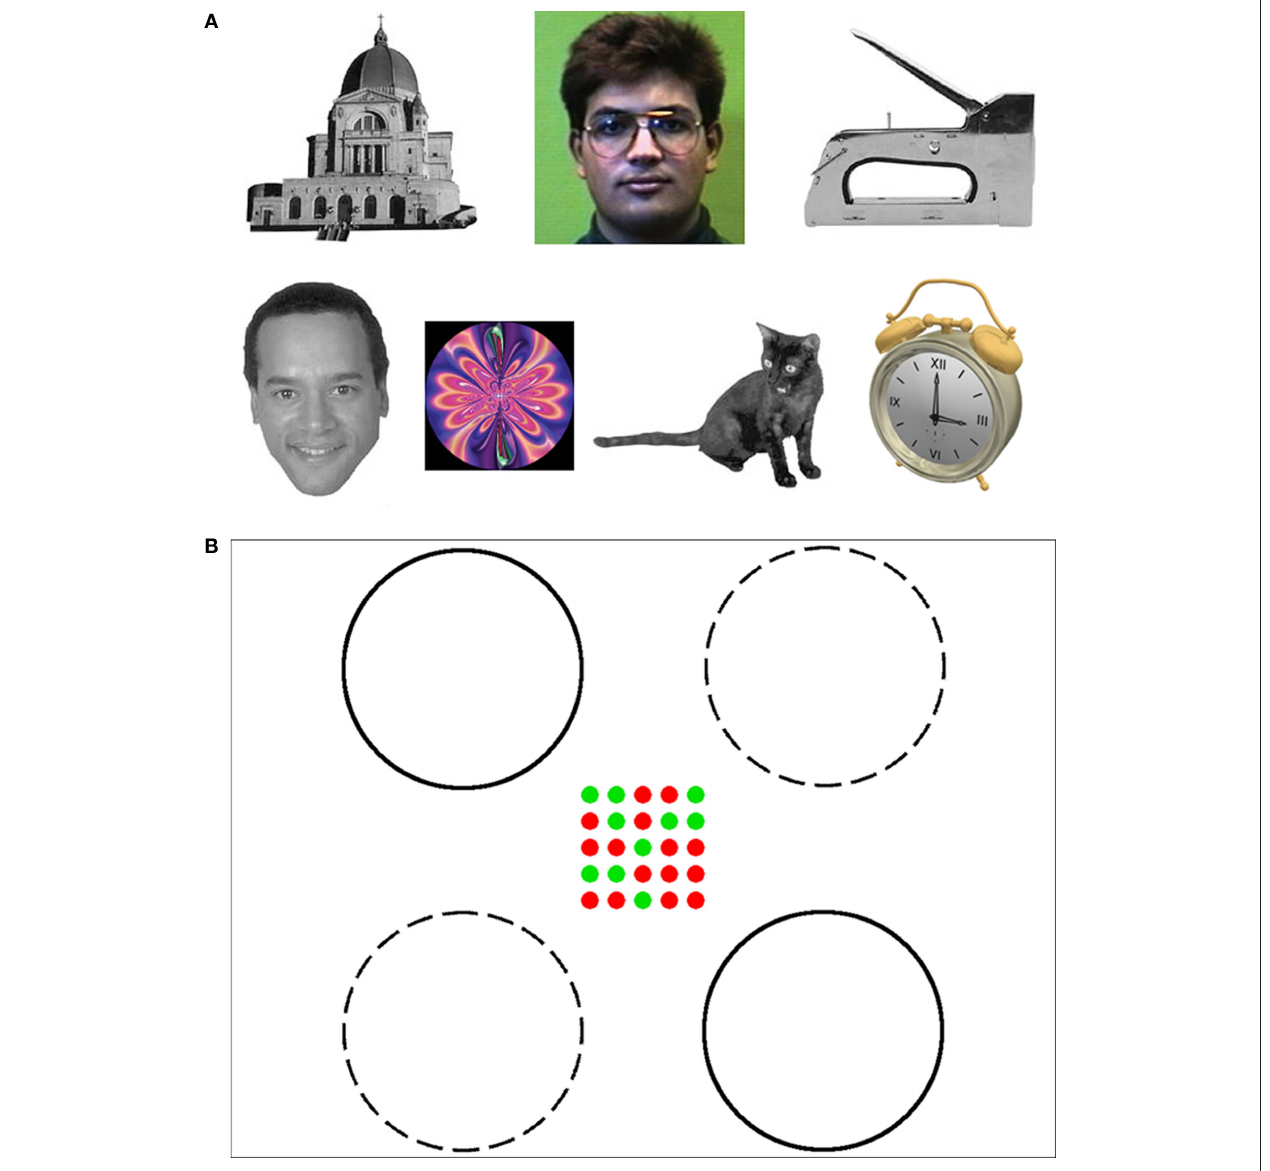
the trials. For Blocks 1–6, distractors could appear in one of the two locations indicated by solid circles (old locations). For Blocks 7 and 8, distractors could appear in one of the old locations, or in one of the locations indicated by the dashed circles (new